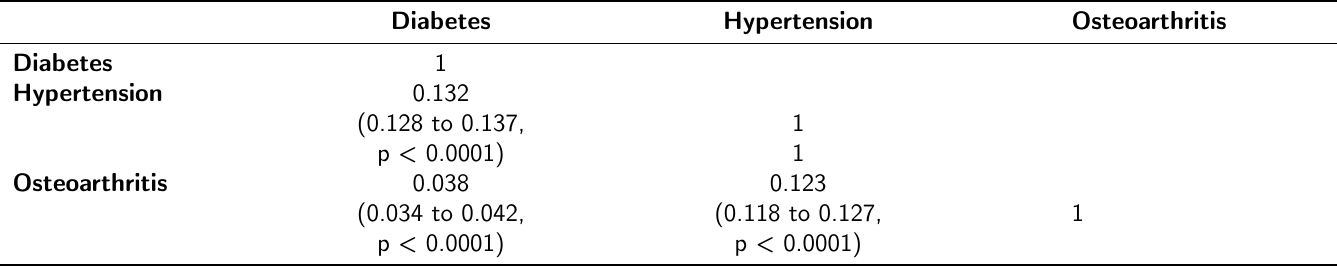
Table 4b: Adjusted correlation (partial correlation)